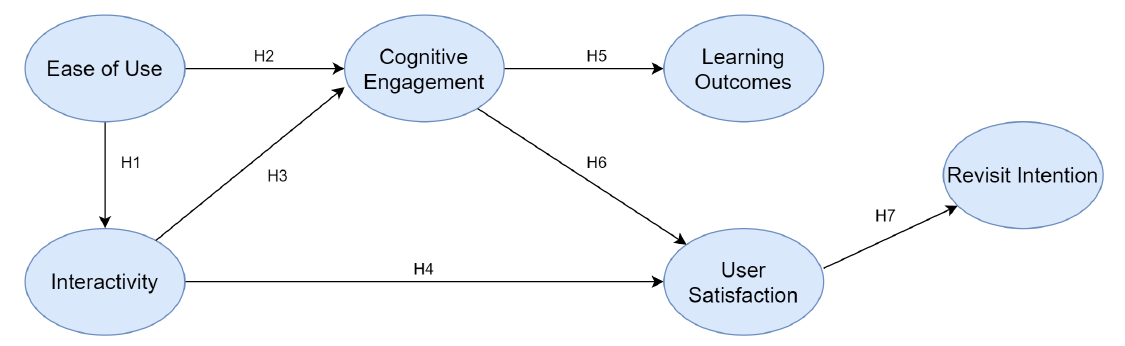
Figure 6. Proposed research